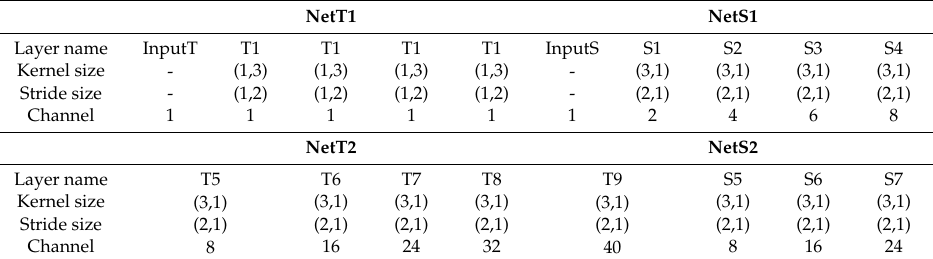
Table 1. Details of the proposed network.